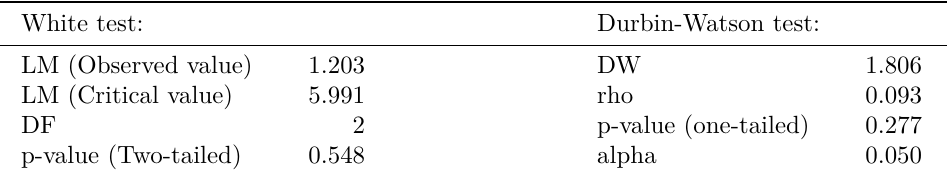
Table A.2: Heteroscedasticity and autocorrelation tests of Model 2 results White test: